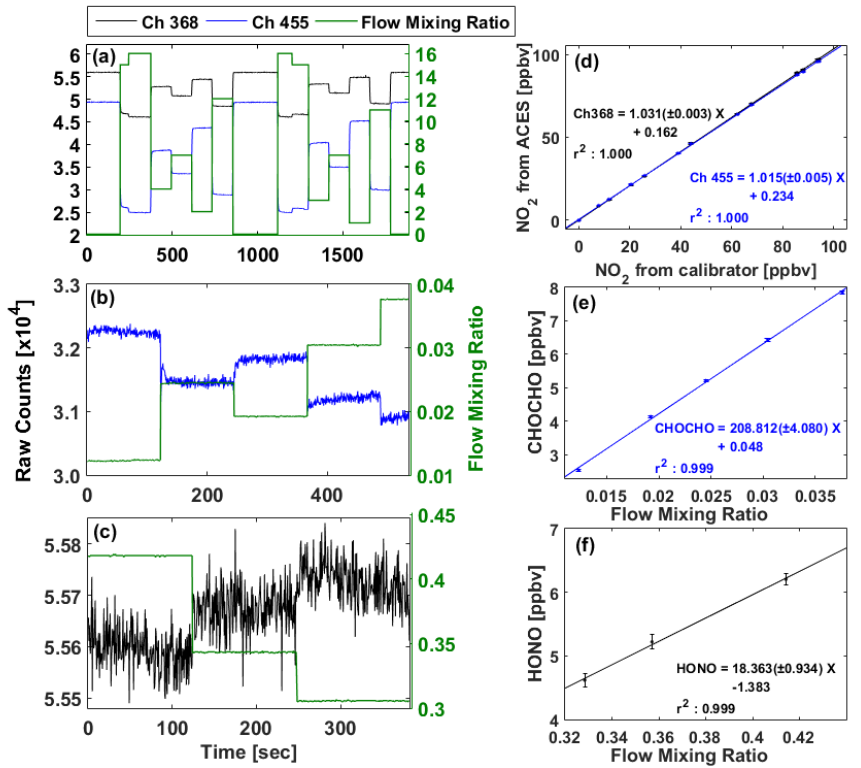
Figure 10. Standard additions of (a) NO 2 , (b) CHOCHO, and (c) HONO. Left axis shows raw data counts for a single pixel at 368nm (Ch 368) and 455nm (Ch 455). Right axis shows flow mixing ratio of target gas, in arbitrary units. Correlation plots for (d) NO 2 , (e) CHOCHO, and (f) HONO showing the average and standard deviation for the bold points in panels (a–c) . All of the comparisons are highly linear, with r 2 = 0.999 or